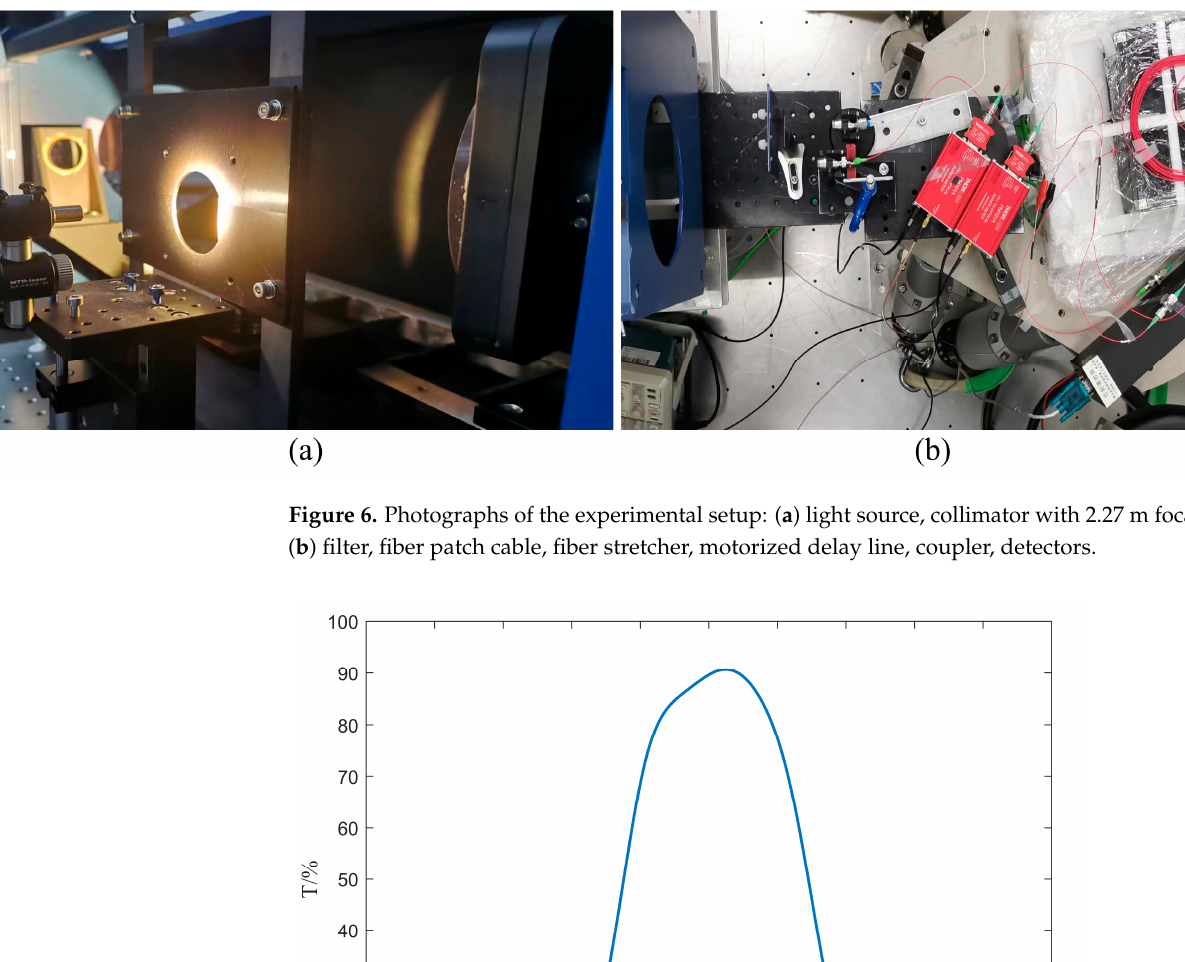
Figure 7. Transmission spectrum of the fi lter.